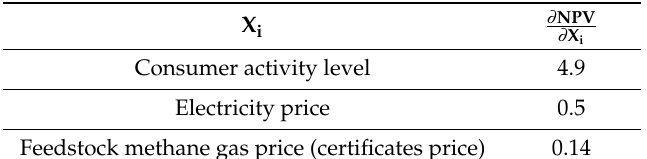
Table 4. Partial derivative of the NPV relative to each of assumed variables.